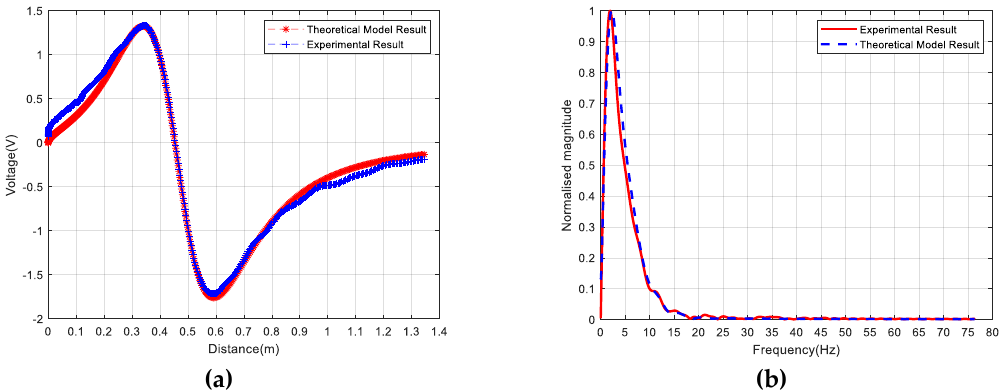
Figure 24. Results of experiment 3: ( a ) Comparison of the theoretical value with the measured voltage; and ( b ) comparison of theoretical spectrum with the measured spectrum of voltage.